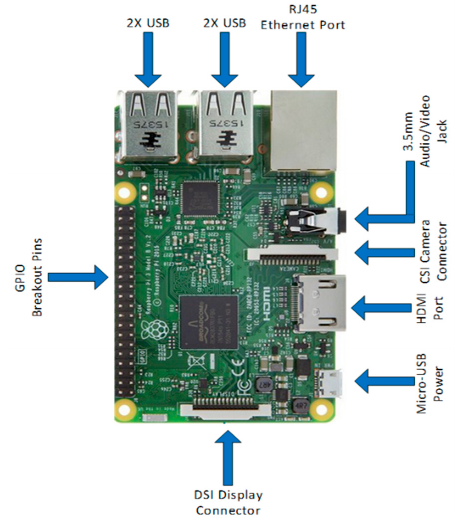
Figure 5. The hardware components of Raspberry Pi 3 Model B [21].